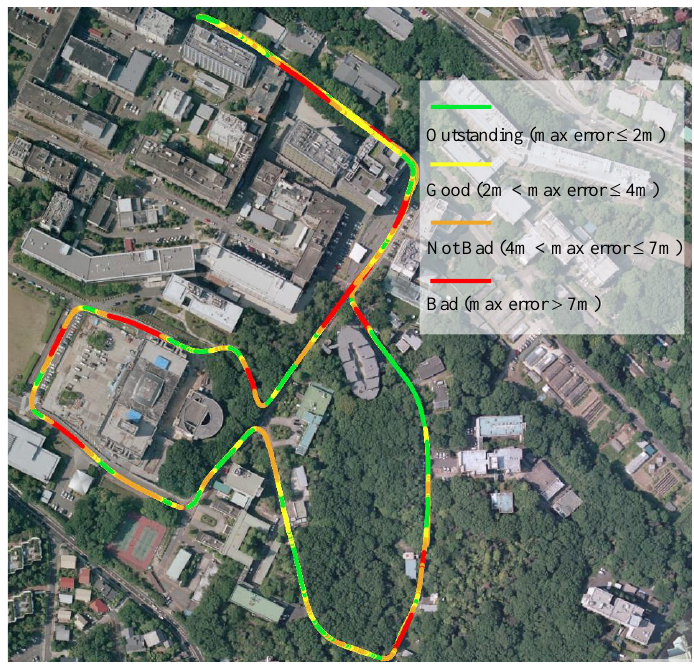
Figure 8. Spatial distribution of max prediction errors along the driving route.